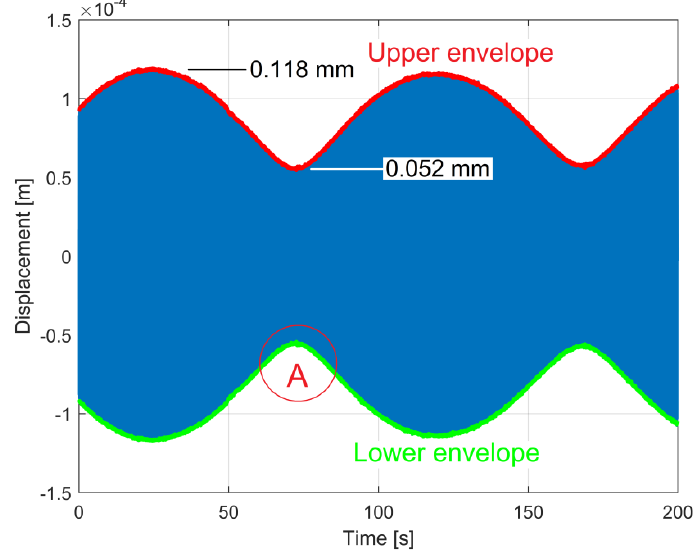
Figure 7. The headstock vibration displacement evolution during the beating phenomenon, deduced by numerical integration and correction of the signal depicted in Figure 3.